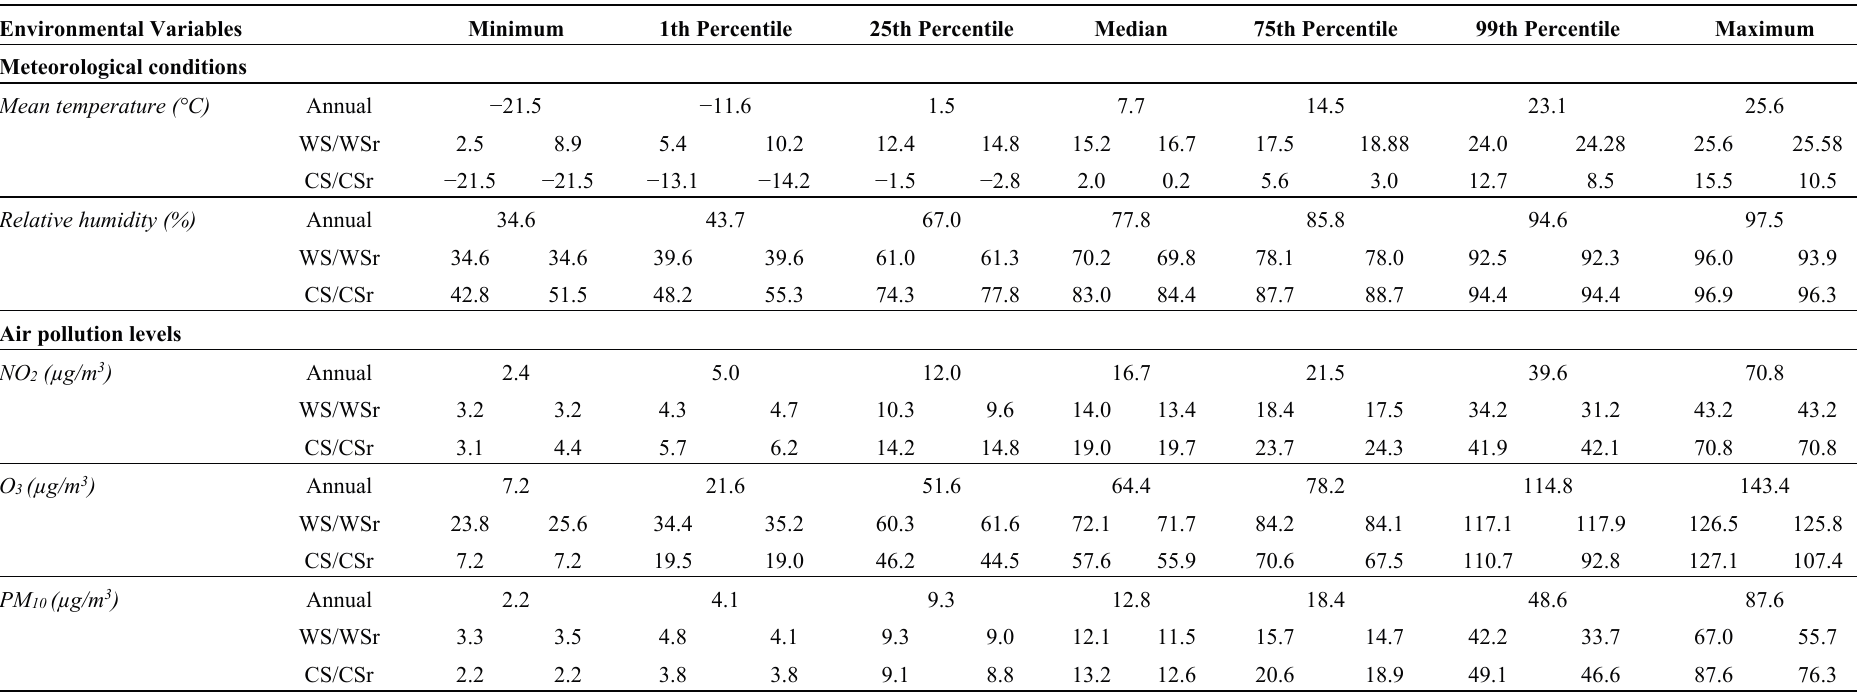
Table 2. Descriptive statistics of the environmental variables in Stockholm